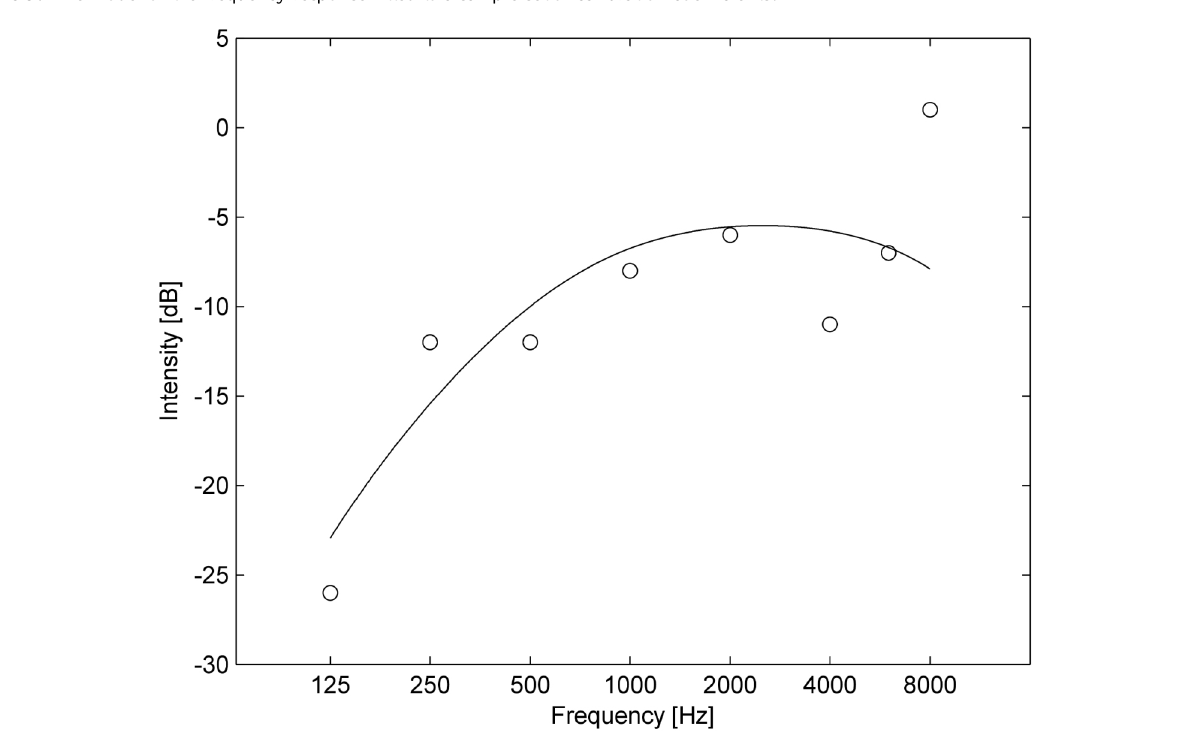
Figure 3. The model of the frequency response fitted to a sample set of calibration coefficients.